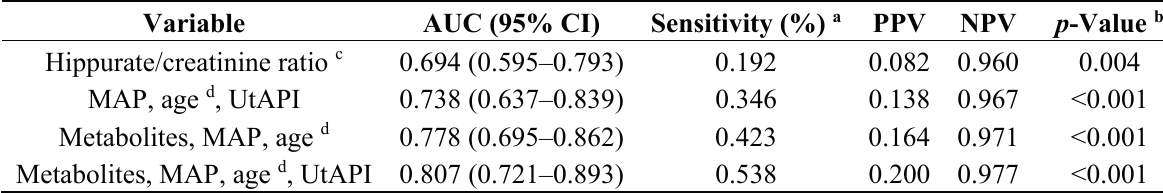
Table 4. Prediction of preeclampsia based on urinary metabolites and maternal characteristics in logistic